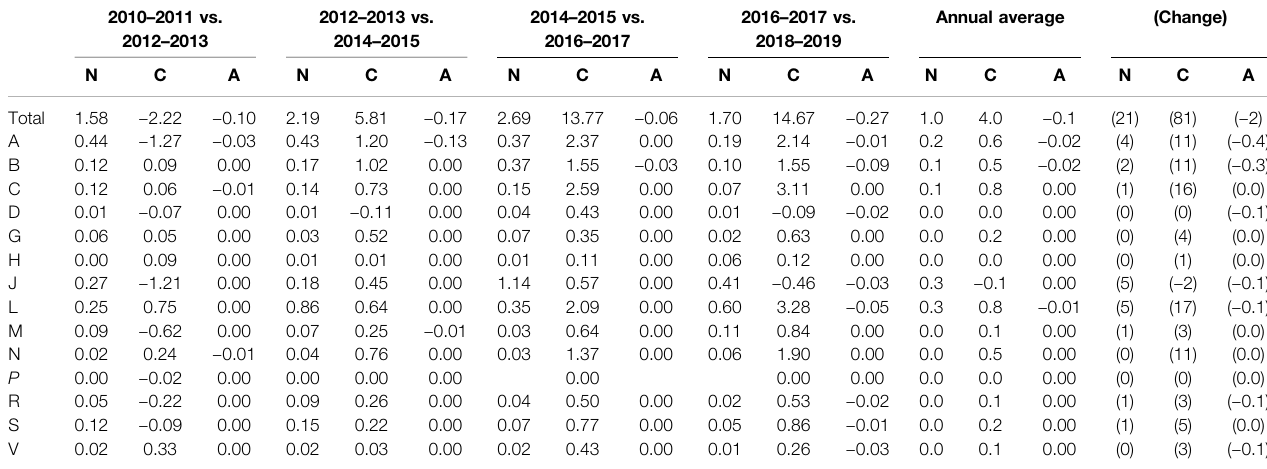
TABLE 3 | Contributions to changes in pharmaceutical spending by two-year periods for ATC level 1 groups of medicines